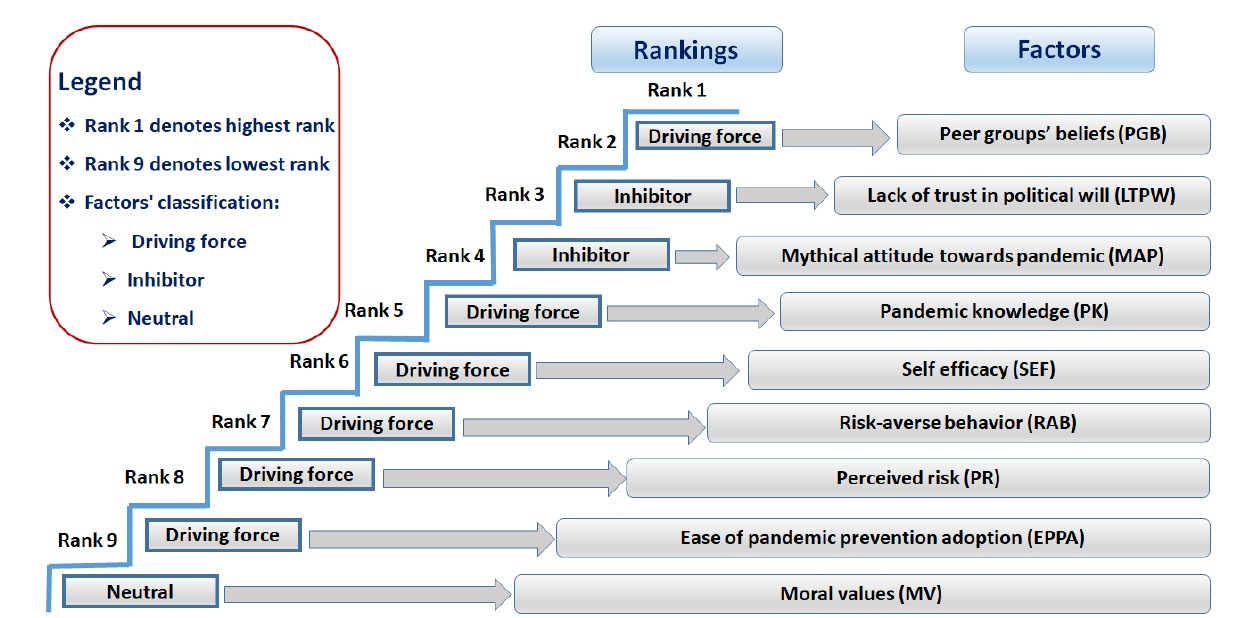
Figure 4. Ranking the significance of intention-based critical factors (ICFs) affecting individuals’ willingness to adopt pandemic prevention (WAPP). Source: Authors’ elaboration. Int. J. Environ. Res. Public Health 2021 , 18 , x